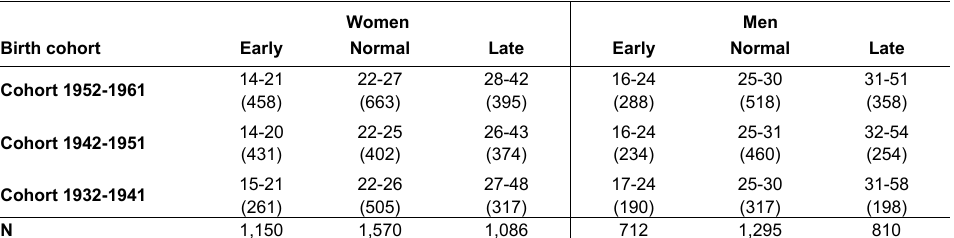
Table 1 : Timing of first parenthood in years (minimum to maximum age), by sex and birth cohort (number of bases in parentheses) Women Men Birth cohort Early Normal Late Early